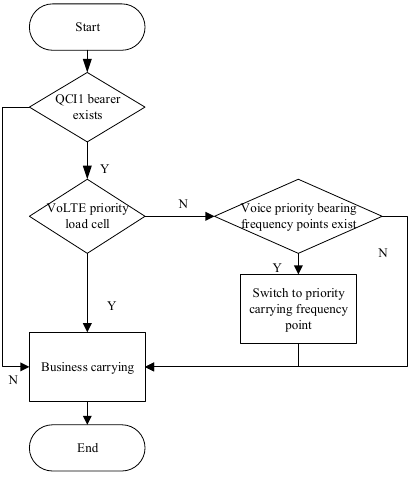
Figure 3. Based on service type handover process.